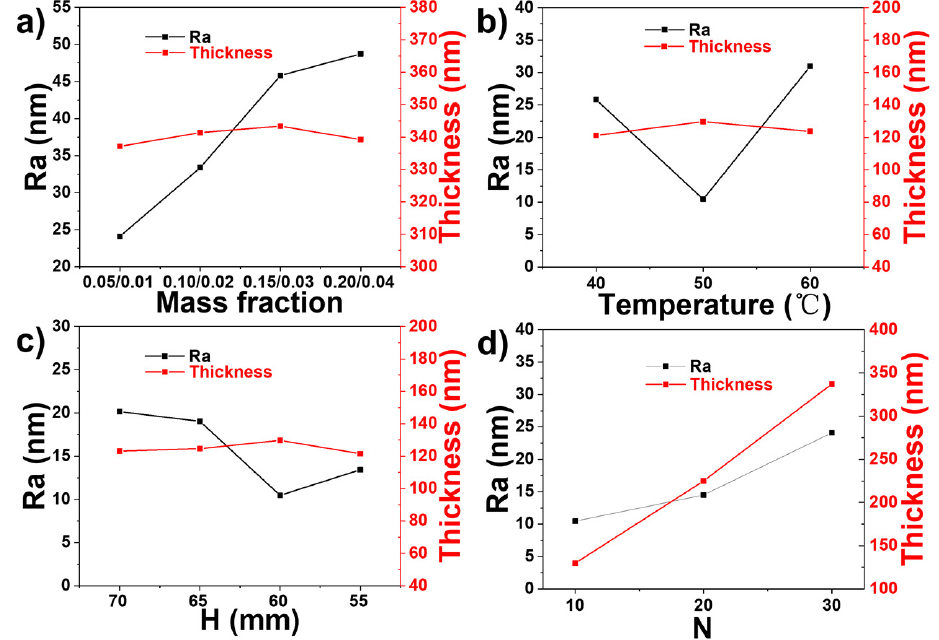
Figure 5. Ra and thickness of SiO 2 /PVP film with ( a ) solution concentrations of 0.05/0.01, 0.1/0.02, 0.15/0.03, and 0.2/0.04 (T = 50 ◦ C and H = 60 mm); ( b ) temperature of = 40 ◦ C, 50 ◦ C, and 60 ◦ C (concentration of 0.05/0.01 and H = 60 mm); ( c ) nozzle-to-substrate distance of 70, 65, 60, and 55 mm (concentration of 0.05/0.01 and T = 50 ◦ C); ( d ) number of spraying passes of 10, 20, and 30 (concentration of 0.05/0.01, T = 50 ◦ C, and H = 60 mm).